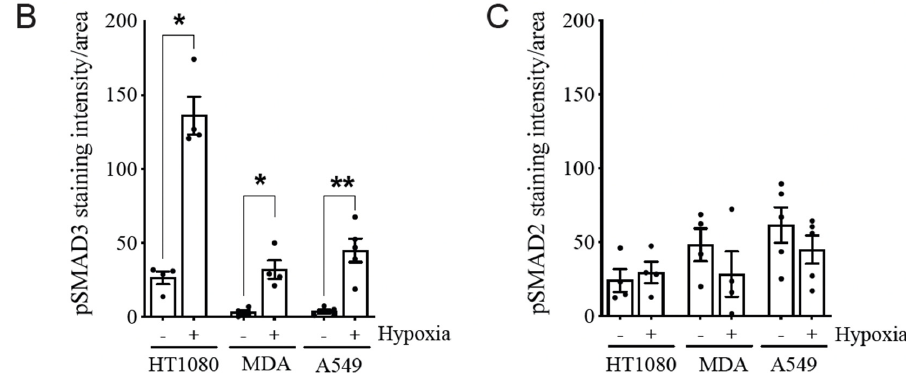
Figure 2. Hypoxia Selectively Increases pSMAD3 Levels in Tumor Xenografts. ( A ) Representative images of cryosections of HT-1080, MDA-MB-231 and A549 xenograft tumors, grown on CAM, stained for hypoxic areas (hypoxyprobe; red) and pSMAD3 (green). Nuclei were stained with DAPI (blue). Scale bar = 50µm. ( B , C ) Quantitation of pSMAD3 ( B ) and pSMAD2 ( C ) staining intensity in normoxic (hypoxia − ) and hypoxic (hypoxia +) regions. ( n = 3–4 experiments; >4 regions analyzed in each experiment). Data are presented as mean ± SEM. * p < 0.05; ** p < 0.01.